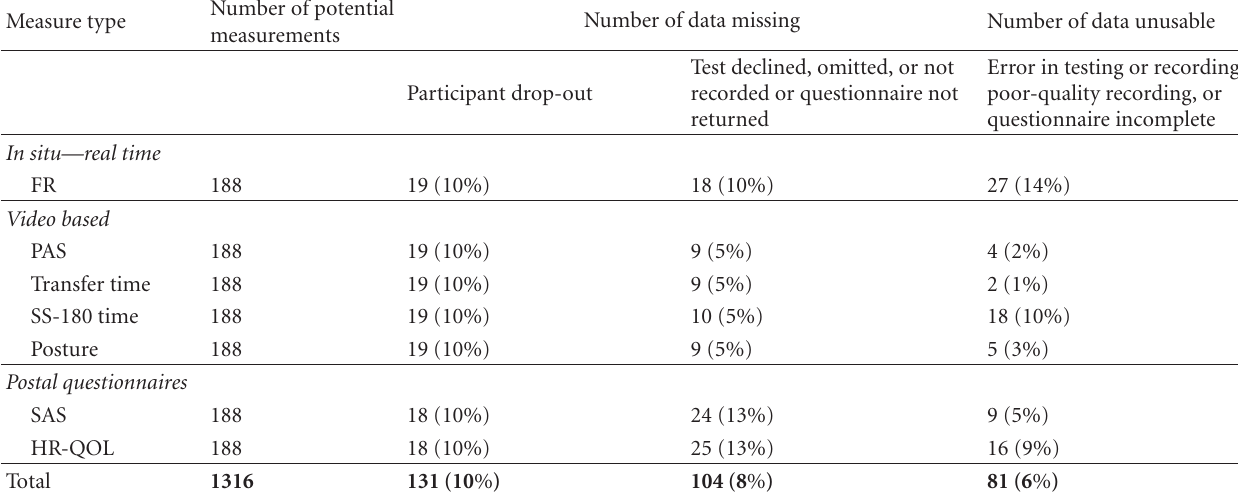
Table 3: Reasons for missing and unusable data, by measure